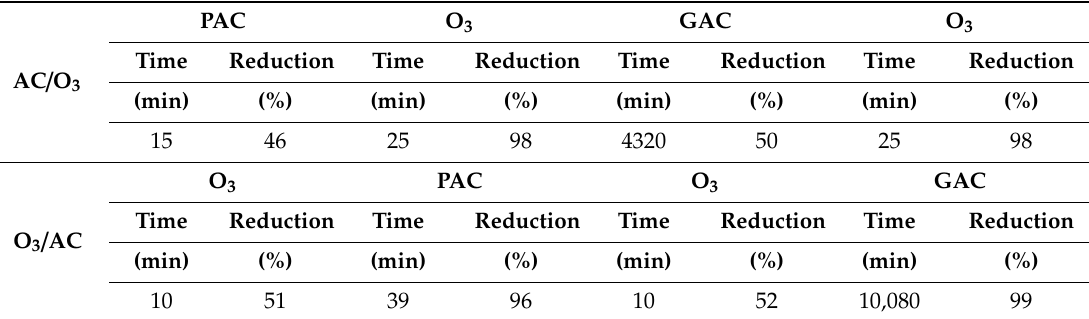
Table 3. Comparison of simazine reduction percentages for AC / O 3 and O 3 / AC. Initial